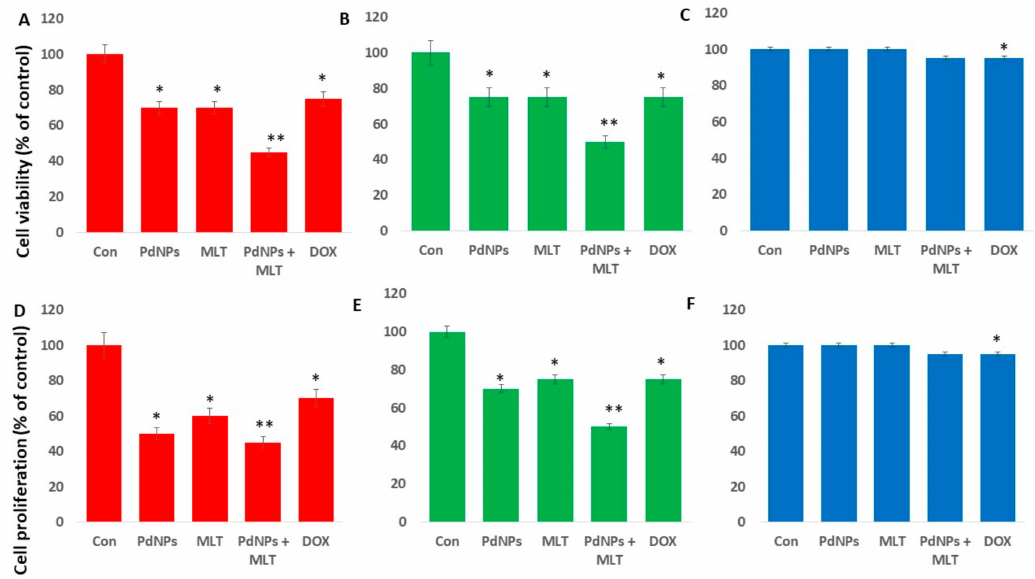
Figure 3. E ff ects PdNPs + MLT on cell viability and proliferation. Cell viability of A549 ( A ) H1229 ( B ) and L132 ( C ) cells and cell proliferation of human adenocarcinoma cells A549 ( D ), H1229 ( E ), and L132 ( F ) in each of the following treatments: control, 2.5 µ M PdNPs, 0.75 mMMLT, 2.5 µ M PdNPs combined with 0.75 mM MLT, and 5 µ M DOX. Results are shown as the mean ± standard deviation of three independent experiments. The treated groups showed statistically significant di ff erences from the control group per Student’s t -test. * p < 0.05 was considered significant; ** p < 0.01 was considered highly